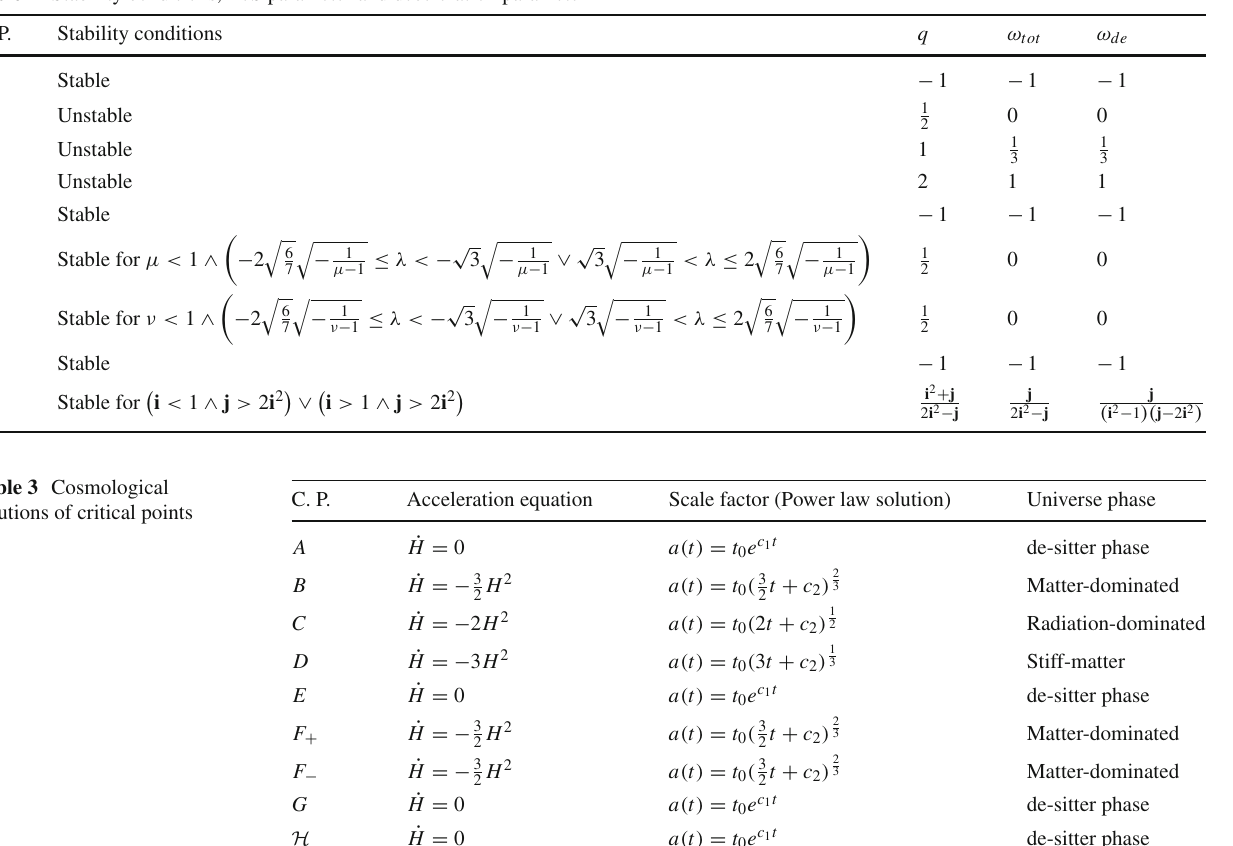
Table 2 Stability conditions, EoS parameter and deceleration parameter C. P.